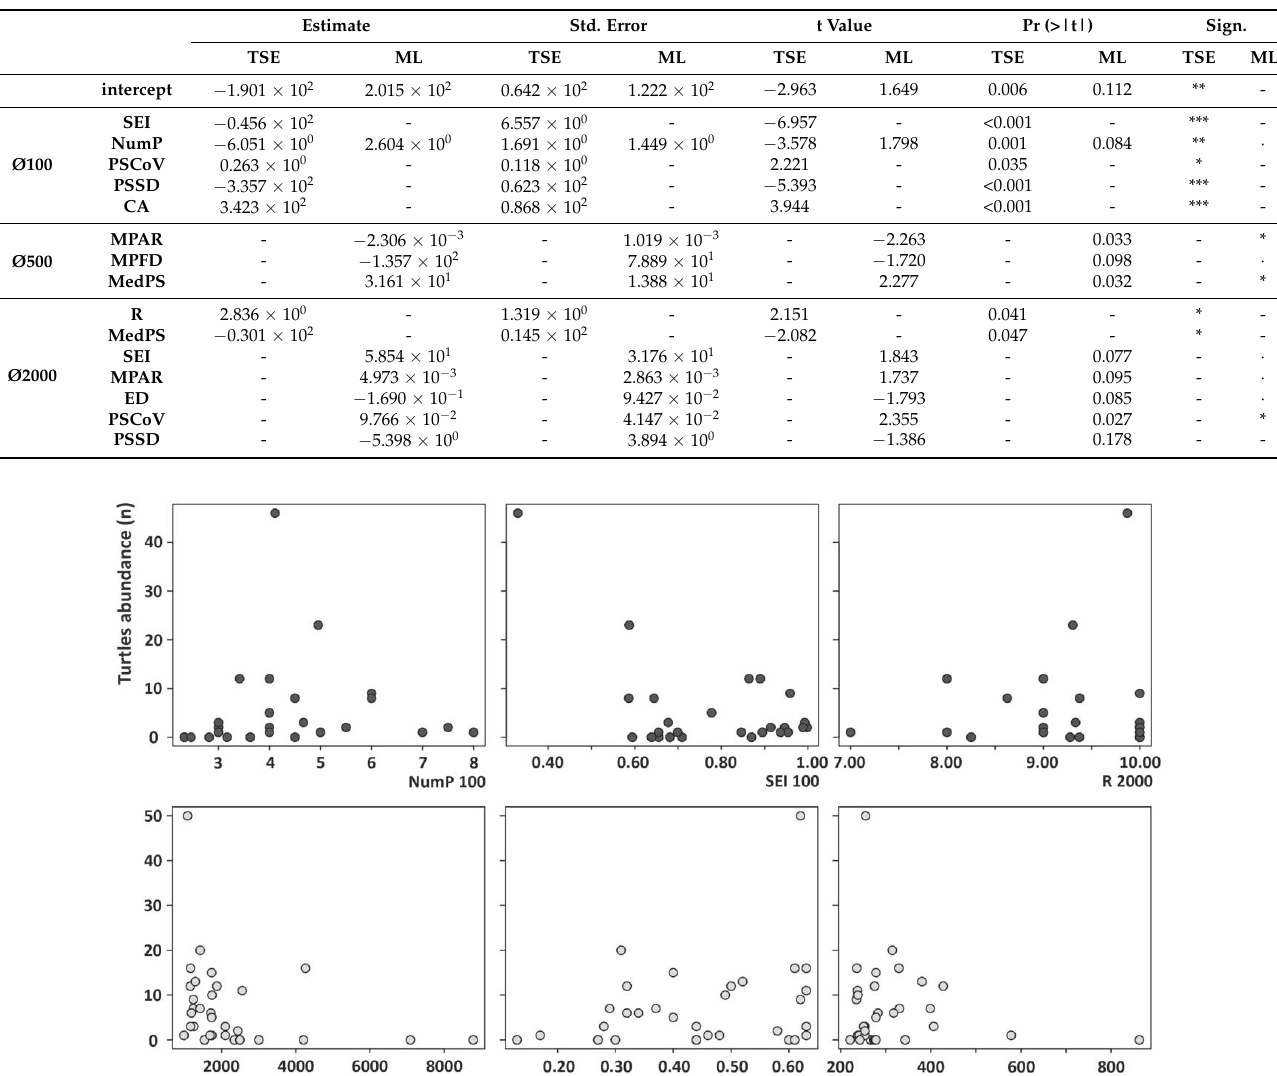
Table 5. Statistical values and significance of each variable in the models built for each species using landscape variables at different spatial scales. Buffer diameters related to different movement types of